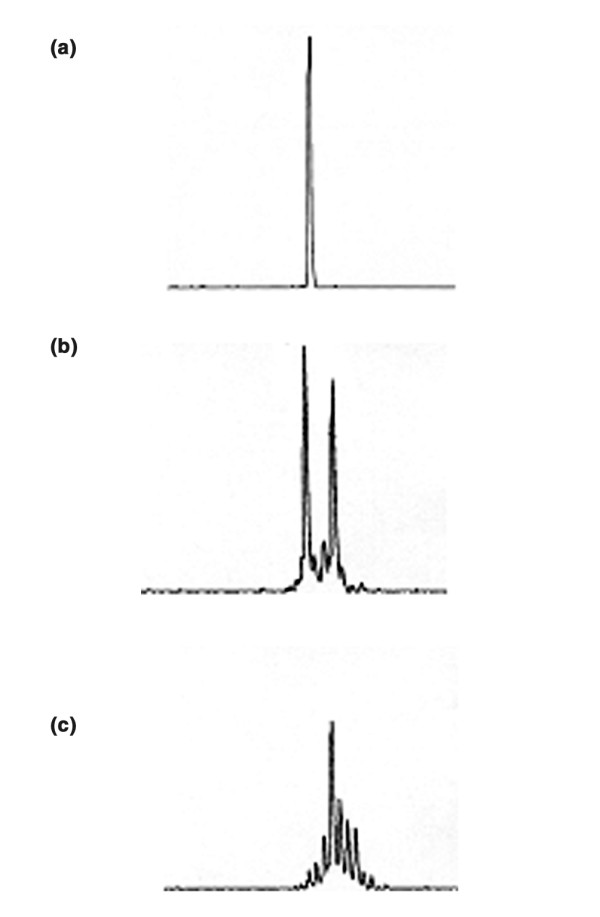
Clonality of T-cell populations. (a) Monoclonal: one peak. (b) Oligoclonal: two to four peaks. (c) Polyclonal: more than four peaks.